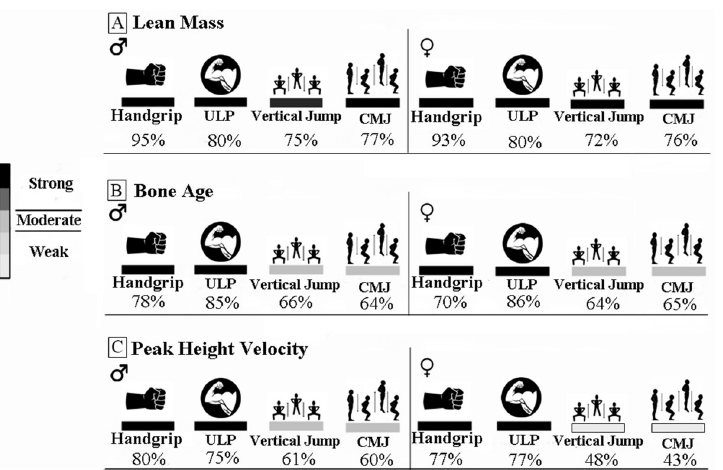
Fig 2. Analysis of MLP’s to indicate the capacity of lean mass, bone age and peak height velocity in predicting the neuromuscular variables of the present study. % = Prediction percent. ♂ = Male sex. ♀ = Female sex. ULP = Upper limbs power. CMJ = Countermovement jump. A = Lean mass as predictor of handgrip, upper limbs power, vertical jump and countermovement jump. B = Bone age as predictor of handgrip, upper limbs power, vertical jump and countermovement jump. C = Peak height velocity as predictor of handgrip, upper limbs power, vertical jump and countermovement jump.